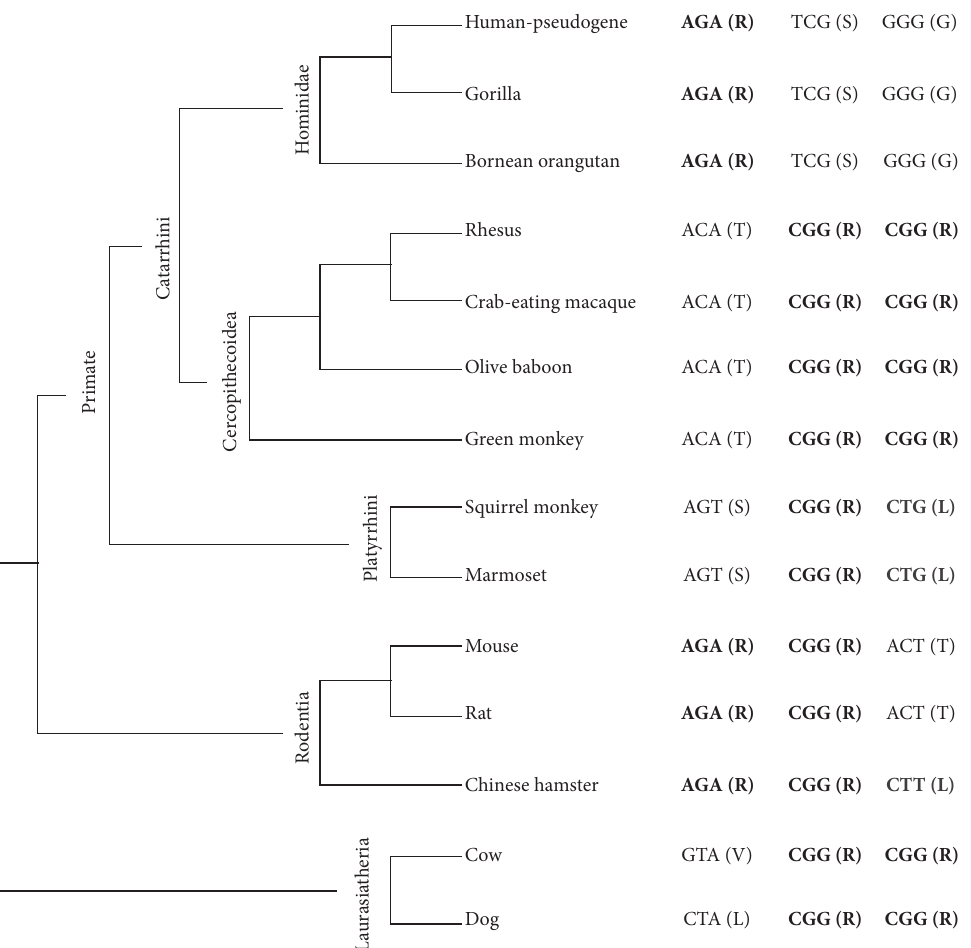
Figure 1: Phylogenetic tree for iGb3 gene indicated three sites under diversifying selection in accordance with MEME. The sites that are shared by different taxa are highlighted in bold. Tree constructed using PhyML, 100 replicates, under GTR + G model. Lnl = − 4263.35. Values of branches sizes and bootstrap were